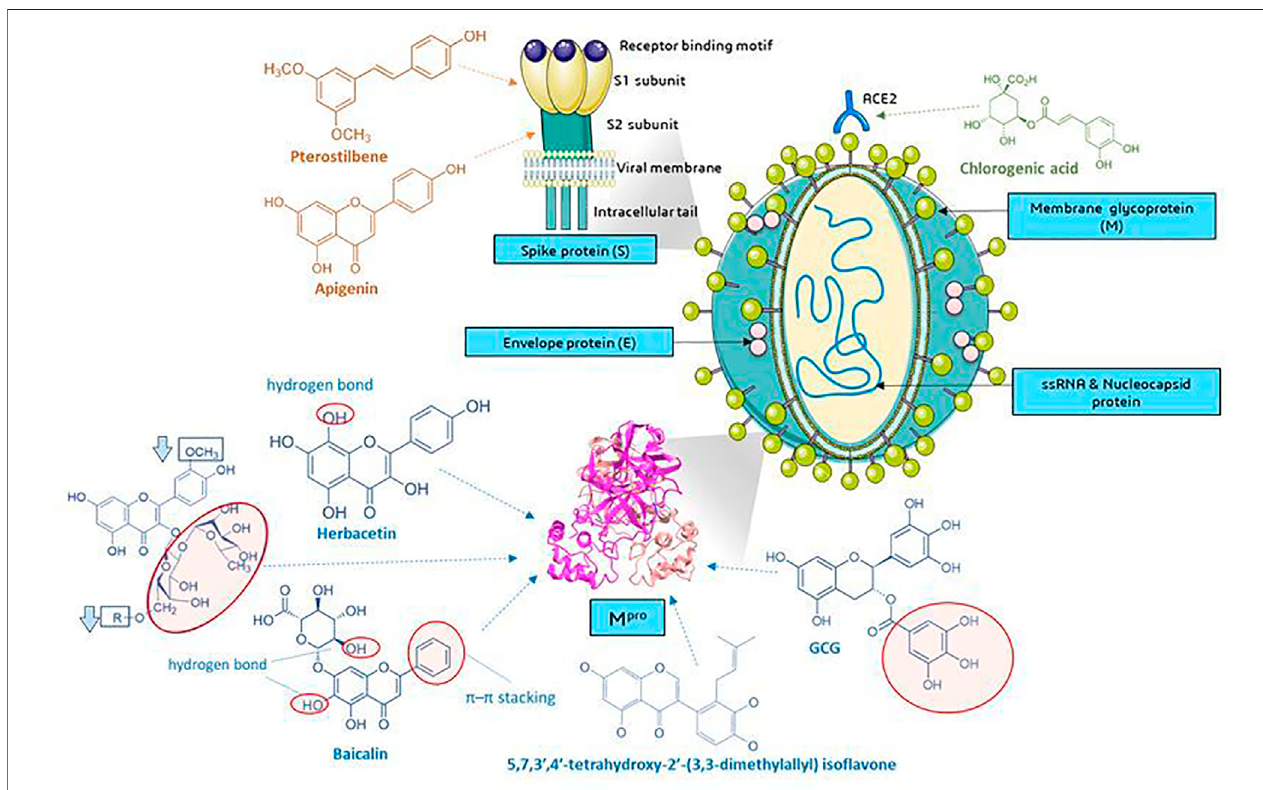
FIGURE 8 | Molecular targets of selected phenolic compounds action on SARS-CoV-2 virus, based on described in vitro and in silico experiments. Spike protein. Molecular docking analysis and the putative binding sites of selected inhibitors on SARS-CoV-2S (spike protein) in C-terminal of S1 domain: Pterostilbene have lowest value of binding af fi nity -6.7 kcal/mol vs hydroxychlo-roquine -5.6 kcal/mol); S2 domain-apigenin -7.7 kcal/mol (Pandey et al., 2020). M pro ( fi gure presented PDB ID: 6LU7; The crystal structure of COVID-19 main protease in complex with an inhibitor N3). GCG has essential galloyl moiety, which forms four hy-drogen bond interactions with aminoacid residues (Nguyen et al., 2012), the 8-OH moiety present in the herbacetin molecule (Jo et al., 2019a). Baicalein – forms hydrogen bonds and π – π stacking between aminoacid residue and the phenyl moiety (Jo et al., 2020), fl avonoids that increase (red circle) or decrease (rectangle) binding stability into N3 binding site in the COVID-19 main protease (Owis et al., 2020), similar as deccribed Cherrak et al., and da Silva et al., that glycosylated fl avonoids display a stronger inhibitoryactivitythanaglycones(Cherraketal.,2020;daSilvaetal.,2020;Rehmanetal.,2020). Insilico analyzesshowtheformationofstablebondsofchlorogenicacid with Gln325 and Gln42/Asp38 in ACE2 (Yu et al., 2020; Servier Medical Art, 2021). Graphics from https://smart.servier.com/.